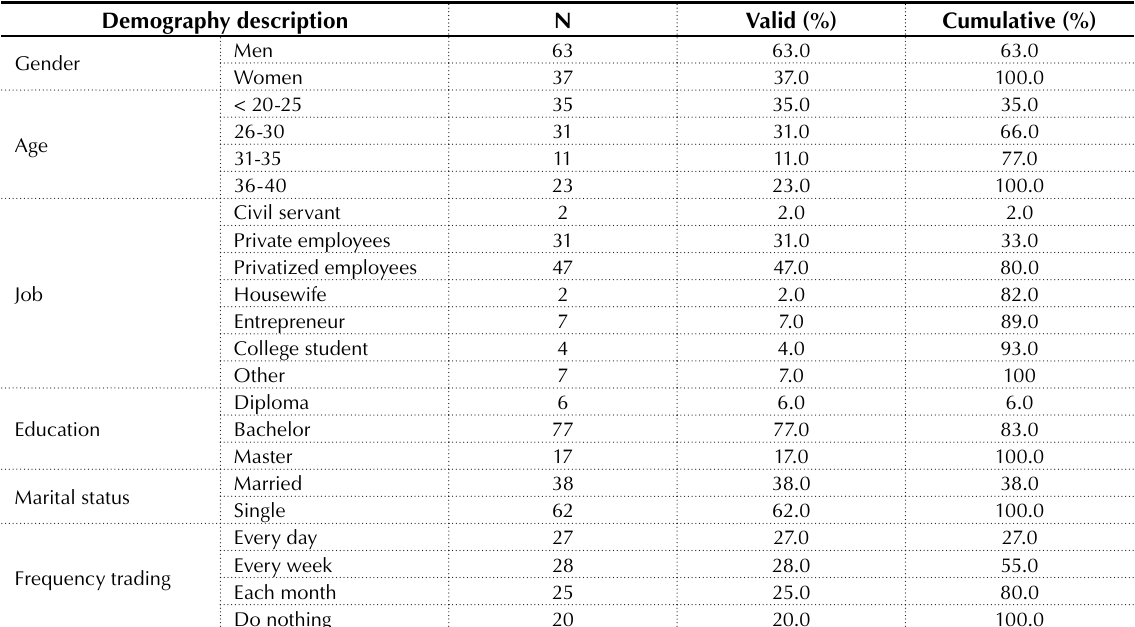
Table 3. Respondentsʼ demography description